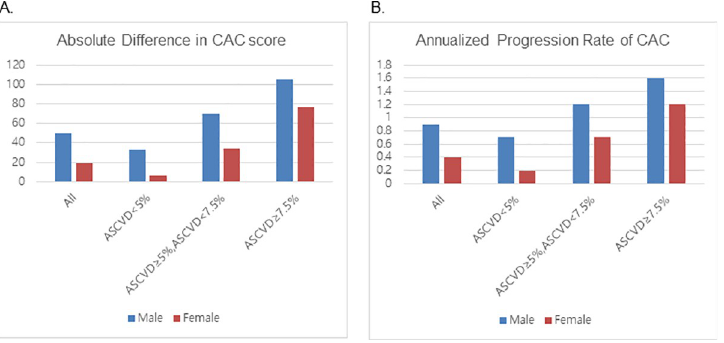
Fig 2. CAC progression for men versus women according to the 10-year ASCVD risk score. (A) Absolute difference in the CAC score between the first and last scanning sessions, (B) Annualized progression rate of CAC. CAC, coronary artery calcium; ASCVD, atherosclerotic cardiovascular